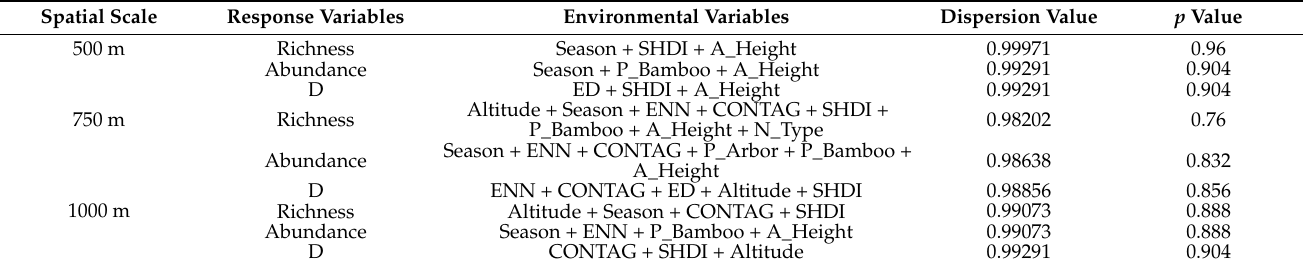
Table 3. The result of step regression with GLM models. SHDI is Shannon–Wiener landscape diversity index; A_Height is the average canopy height; P_Bamboo is percentage of bamboo; ED is edge density index; ENN is Euclidean nearest-neighbor distance index; CONTAG is contagion index; N_Type is the number of land cover